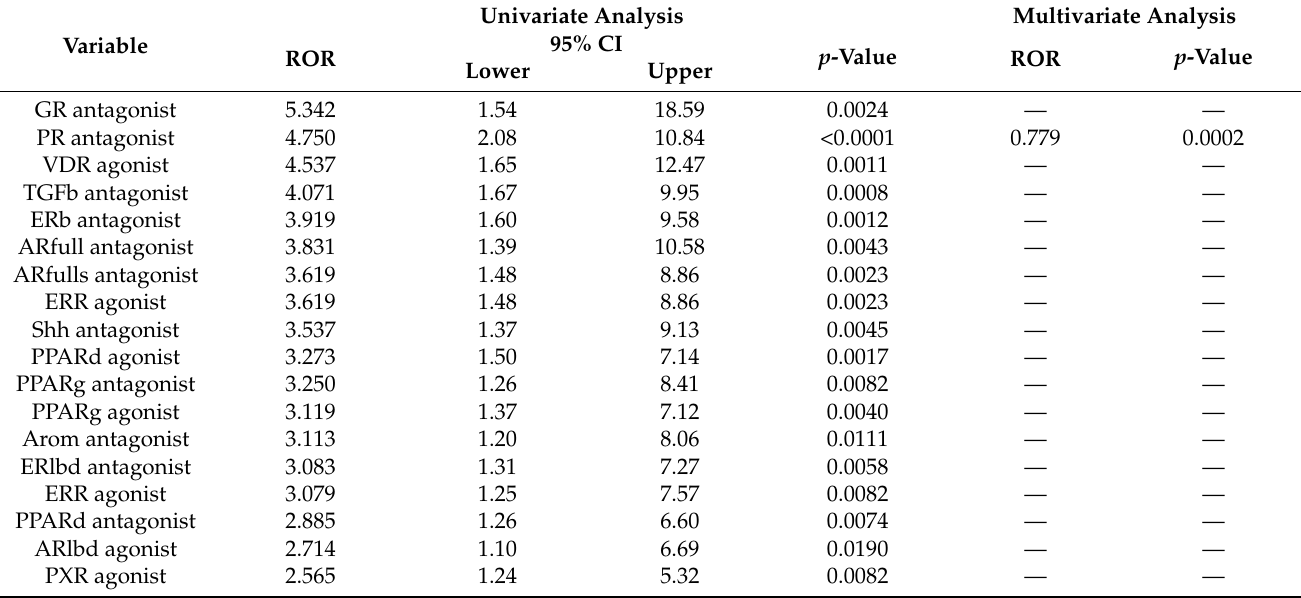
Univariate analysis and multivariate analysis of MIEs associated with diarrhea- inducing